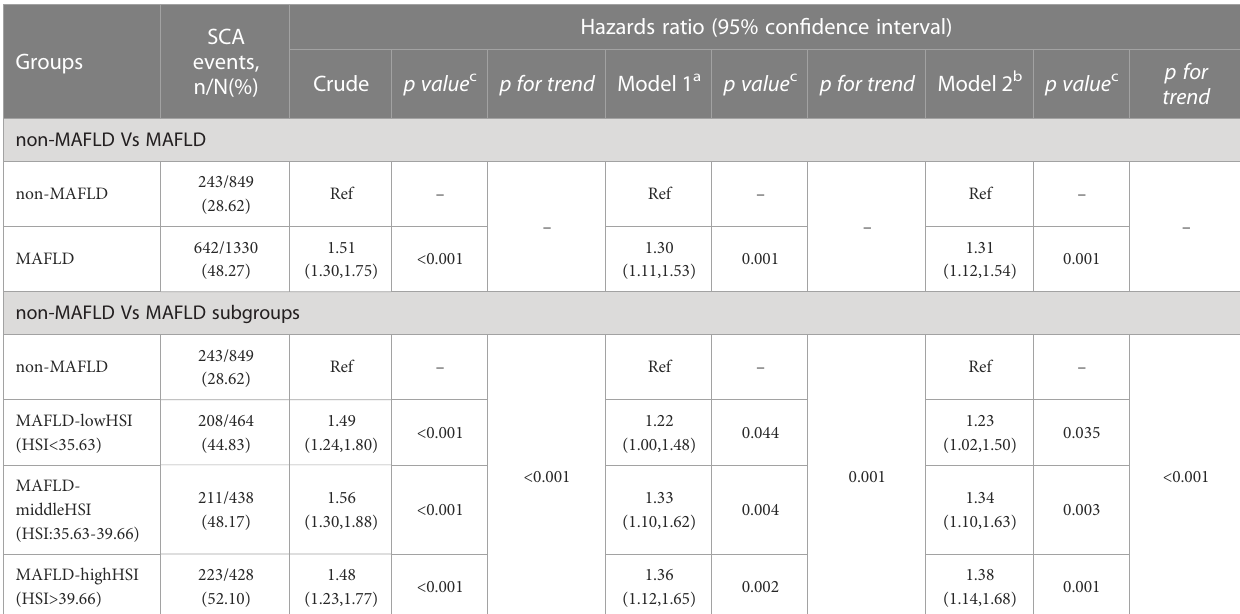
TABLE 4 Association between baseline MAFLD and the incidence of subclinical carotid atherosclerosis in the longitudinal cohort.